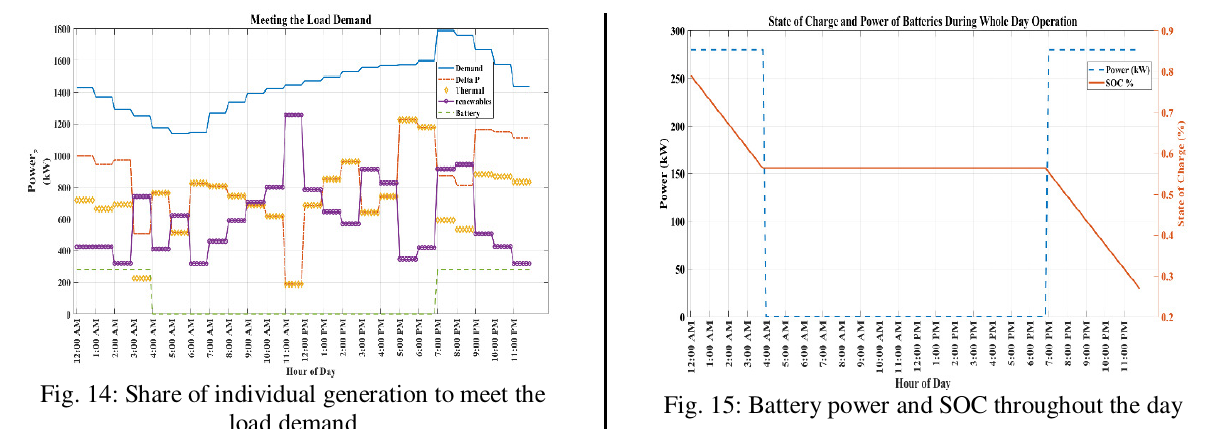
Fig. 15: Battery power and SOC throughout the